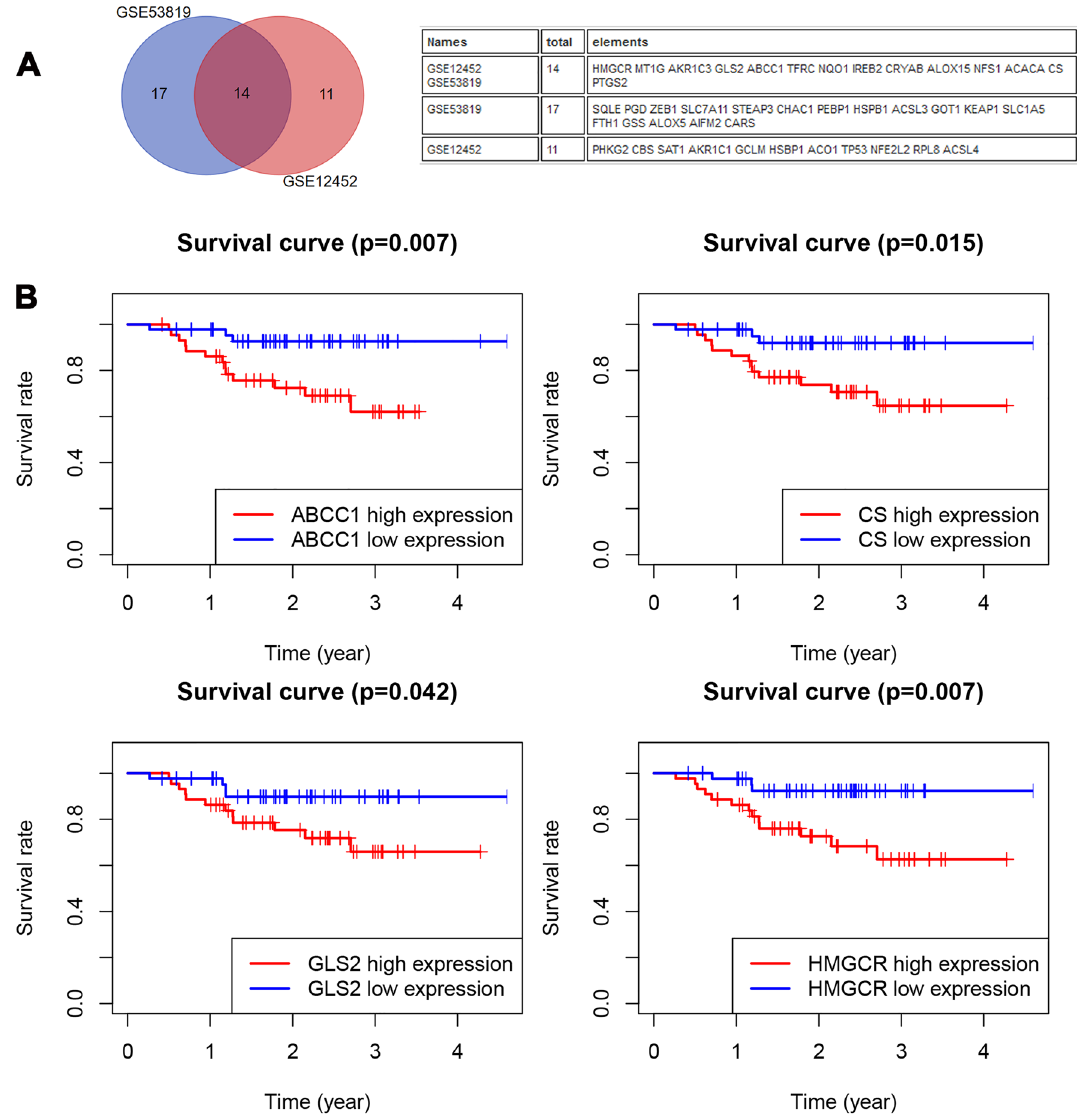
Figure 2. The expression of FRGs in NPC. ( A ) The overlapped DE_FRGs from GSE53819 and GSE12452. ( B ) K–M curves of poor progression-free survival for ABCC1, CS, GLS2 and HMGCR expression in